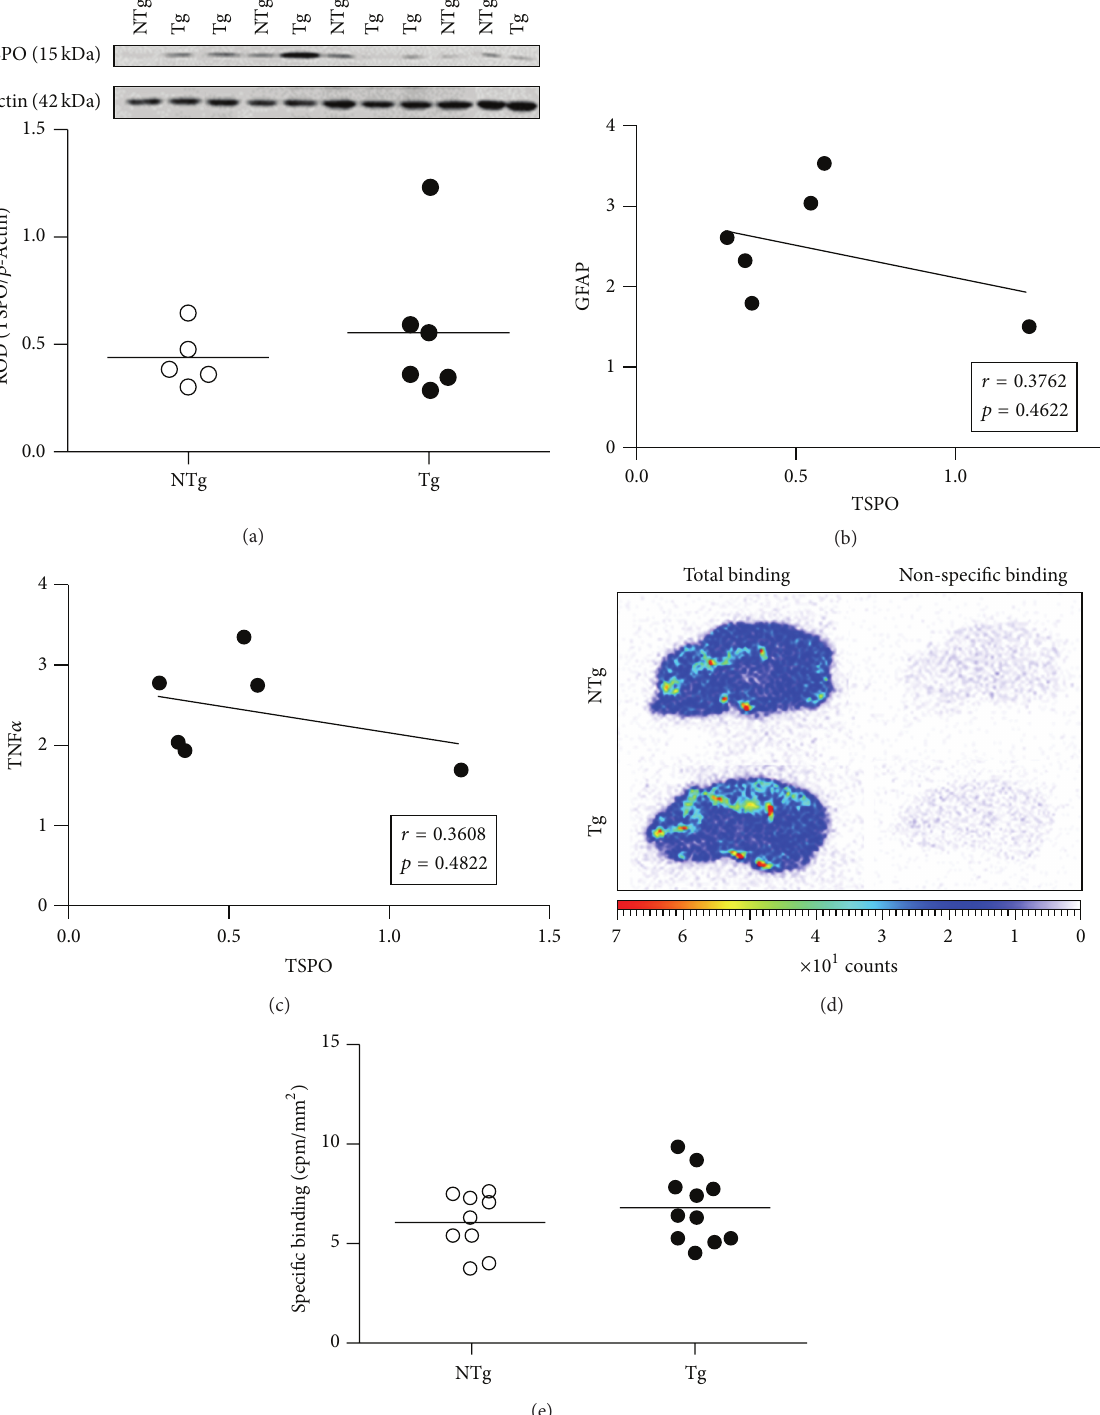
Figure 3: TSPO expression in the hippocampus of 3-month-old WT and APPswe/PS1dE9 mice. (a) Representative immunoblot of TSPO (15kDa) in the hippocampus of WT ( 𝑛 = 5) and APPswe/PS1dE9 ( 𝑛 = 6) mice. Equal protein loading was confirmed by detection of 𝛽 -actin (42kDa) and results were expressed as relative optical density (ROD). (b) In APPswe/PS1dE9 mice, the correlations between TSPO and GFAP ( 𝑟 = 0.3762; 𝑝 = 0.4622 ) and between TSPO and (c) TNF 𝛼 ( 𝑟 = 0.3608; 𝑝 = 0.4822) were not significant. Linear regression analysis (b and c) was performed using the ROD values shown in Figures 3(a), 2(a), and 1(b) for TSPO, GFAP, and TNF 𝛼 , respectively. (d) Representative autoradiographic images obtained on 16 𝜇 m thick sagittal brain sections: total (left panel) and nonspecific (right panel) binding in WT (upper) and T APPswe/PS1dE9 (lower) mice. (e) Quantitative autoradiographic measurements of TSPO density in the hippocampus were expressed as specific binding of [ 3 H]PK-11195 in both groups. Data represent mean of cpm/mm 2 for each WT ( 𝑛 = 9 ) and APPswe/PS1dE9 ( 𝑛 = 11 ) mouse. NTg: wild type; Tg: